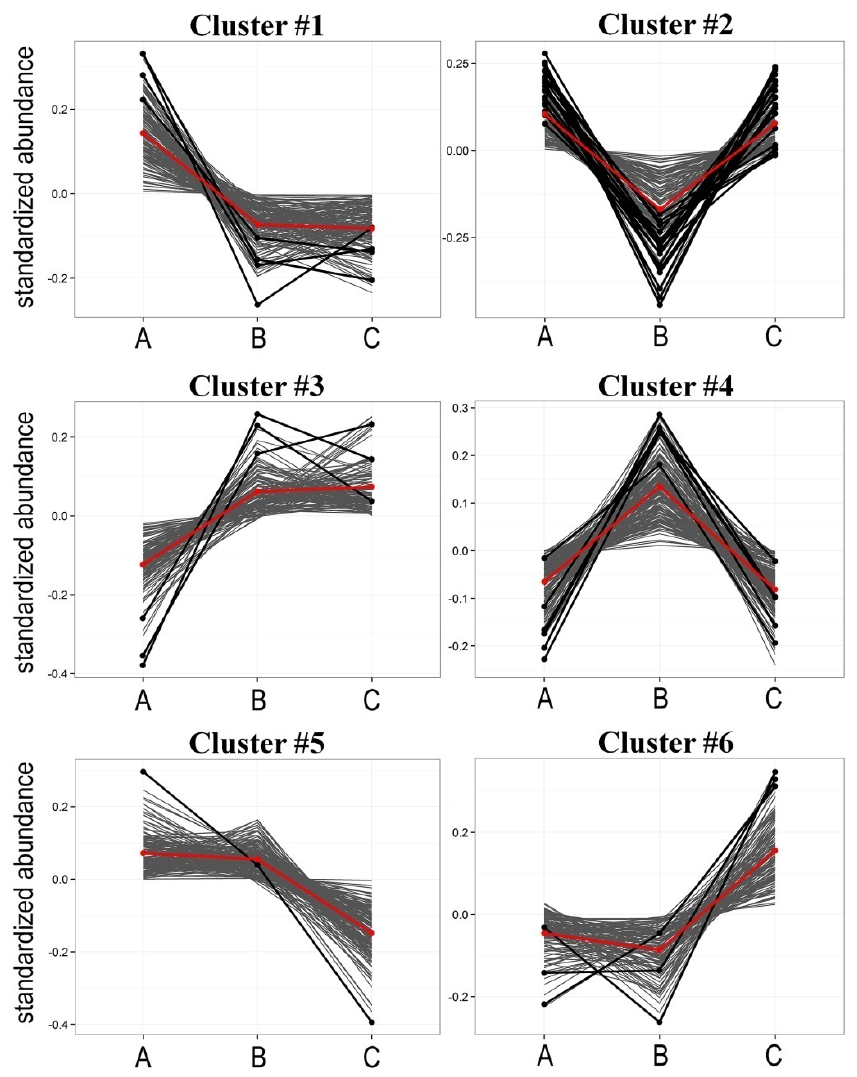
Figure 2. Radiation induced changes followed different patterns. Presented are characteristics of six identified clusters of components with similar time-courses of changes; marked are average profiles for each cluster (red lines) and components that changed abundance significantly (FDR < 5%; solid black lines); other components belonging to each cluster are marked with grey lines.